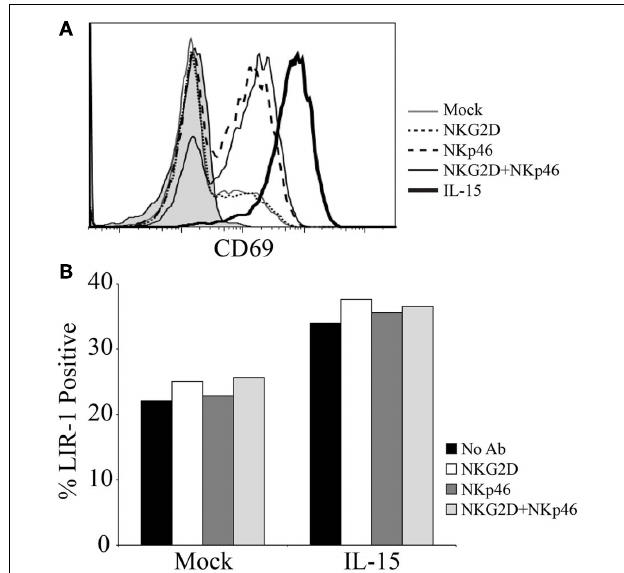
FIGUREA2 |Triggering activating receptors on NK cells does not increase LIR-1 expression. (A) D183 NK cells were isolated from peripheral blood and purity was assessed by CD56 and CD3 expression (data not shown). Anti-human NKG2D (1D11) and anti-human NKp46 (195314) were used at 10 μ g/ml to coat wells of a 96-well plate for NK cell stimulation. NK cells were plated in the presence and absence of IL-15 and incubated for a period of 72h. On day 3, cells were harvested and examined for expression of CD69.The shaded histogram represents the staining profile with an isotype control antibody. (B) NK cells shown in (A) were co-stained for LIR-1 expression.